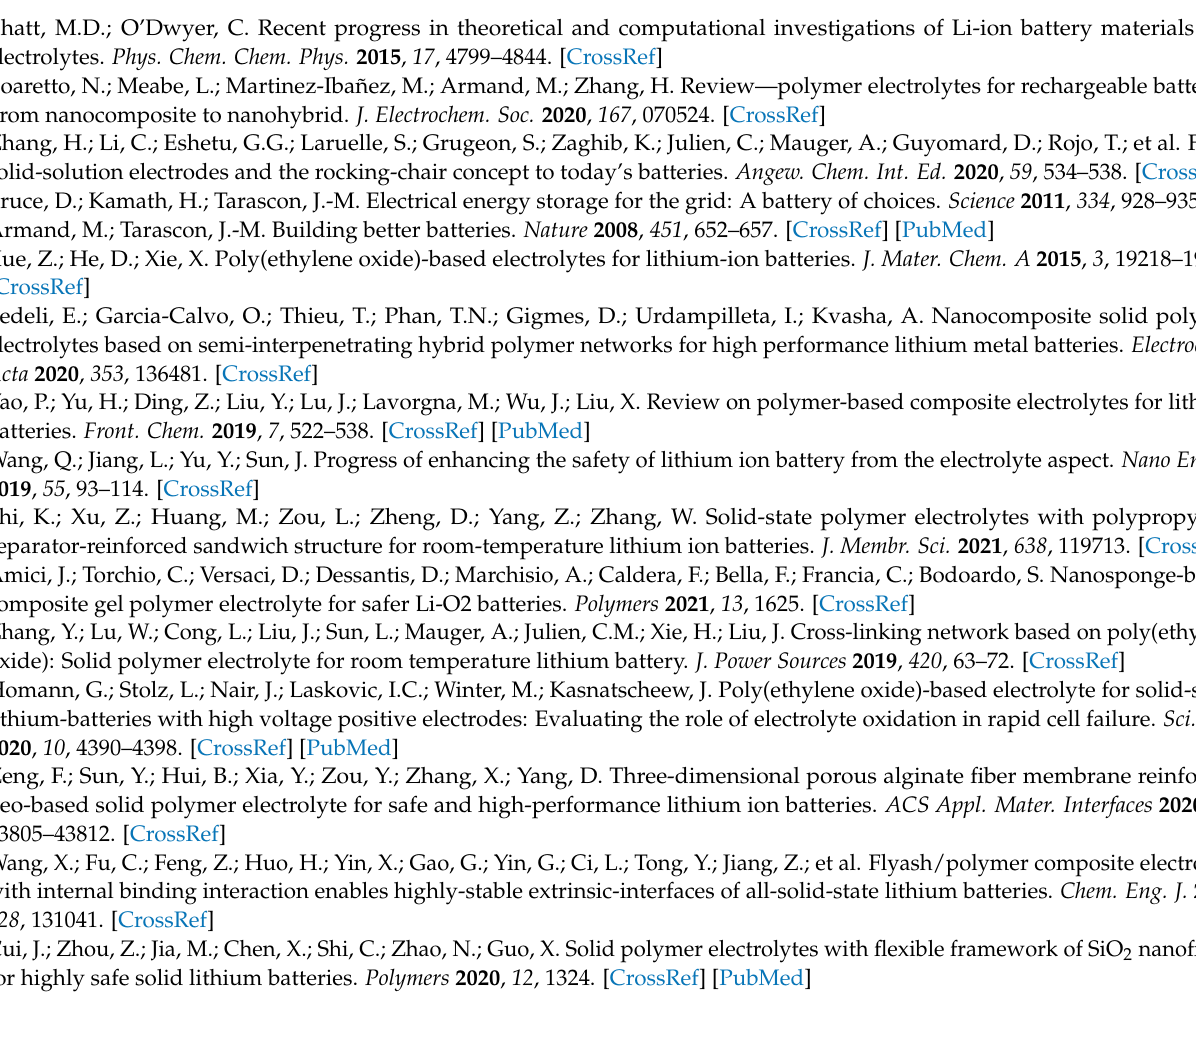
Figure S7: Chronoamperometry profile of the symmetric Li ◦ |T2-20|Li ◦ (inset shows the EIS curves before and after polarization), Figure S8: Specific capacity and Coulombic efficiency vs. cycle number for the Li ◦ |T2-20|LiFePO4 cells at 80 ◦ C, Figure S9: Chronoamperometry profile of the symmetric Li|T3-I|Li (inset shows the EIS curves before and after